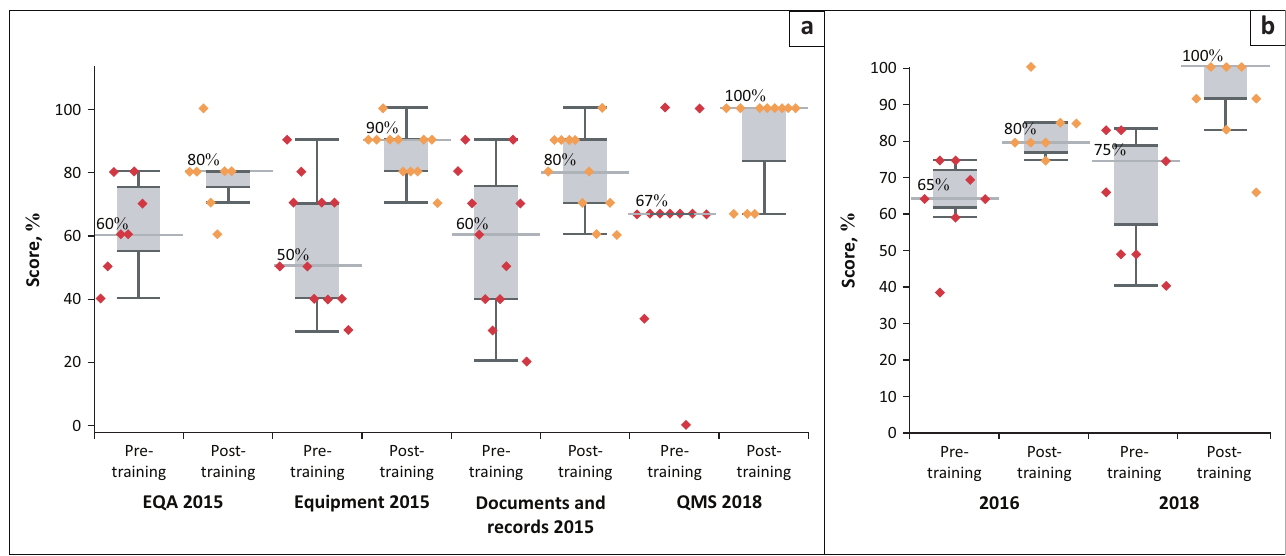
FIGURE 2: Pre- and post-training workshop theoretical test scores of military laboratory staff from quality management (left panel) and biosafety (right panel) workshops, Benin, 2015–2018. Box plots illustrate the distribution of scores among trainees (red diamonds for pre-training and yellow diamonds for post-training) and grey horizontal lines with data labels indicate median score across all the trainees. The interquartile range shows how the data are dispersed by dividing the data into quartiles (depicted by the dark and grey horizontal lines). (a) QMS training: test scores, (b) BS&S training: test